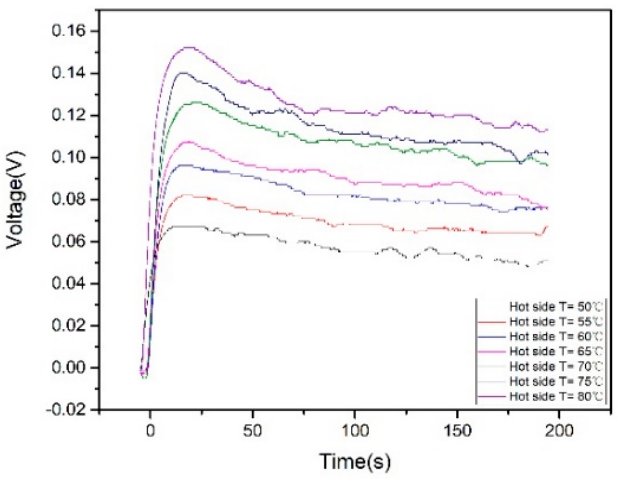
Figure 5. Open circuit voltages of TEGs with different hot side temperatures. Table 1. Performance of TEGs with different hot side temperatures.